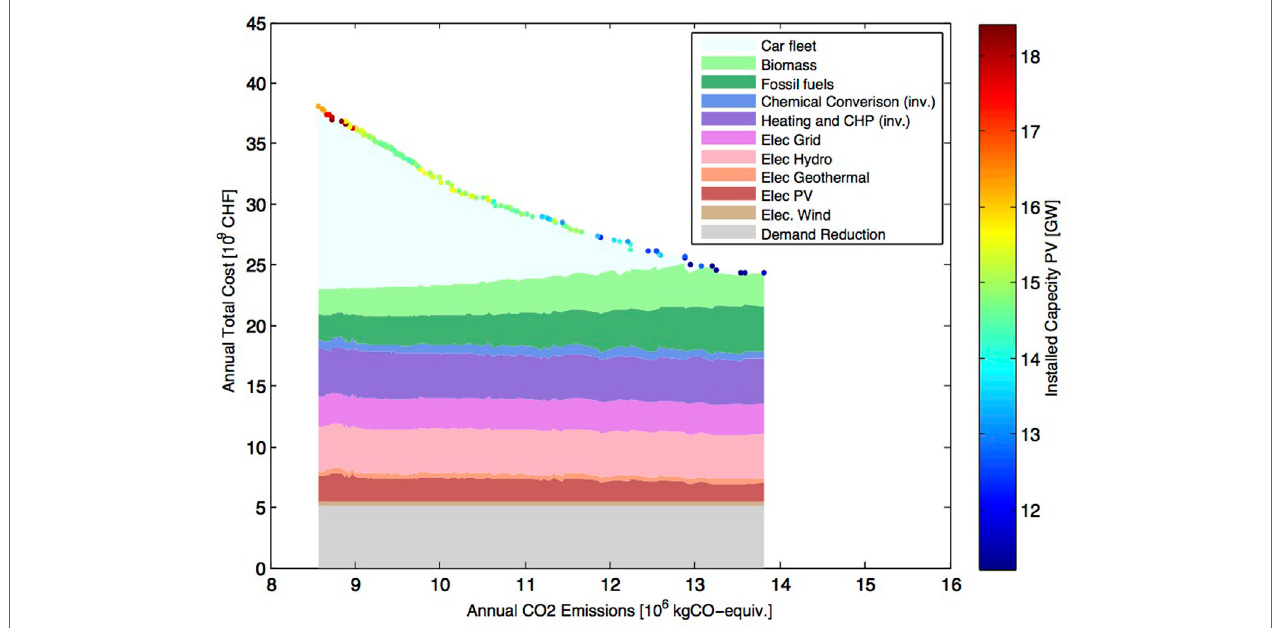
FigUre 12 | Composition of the cost of the pareto front